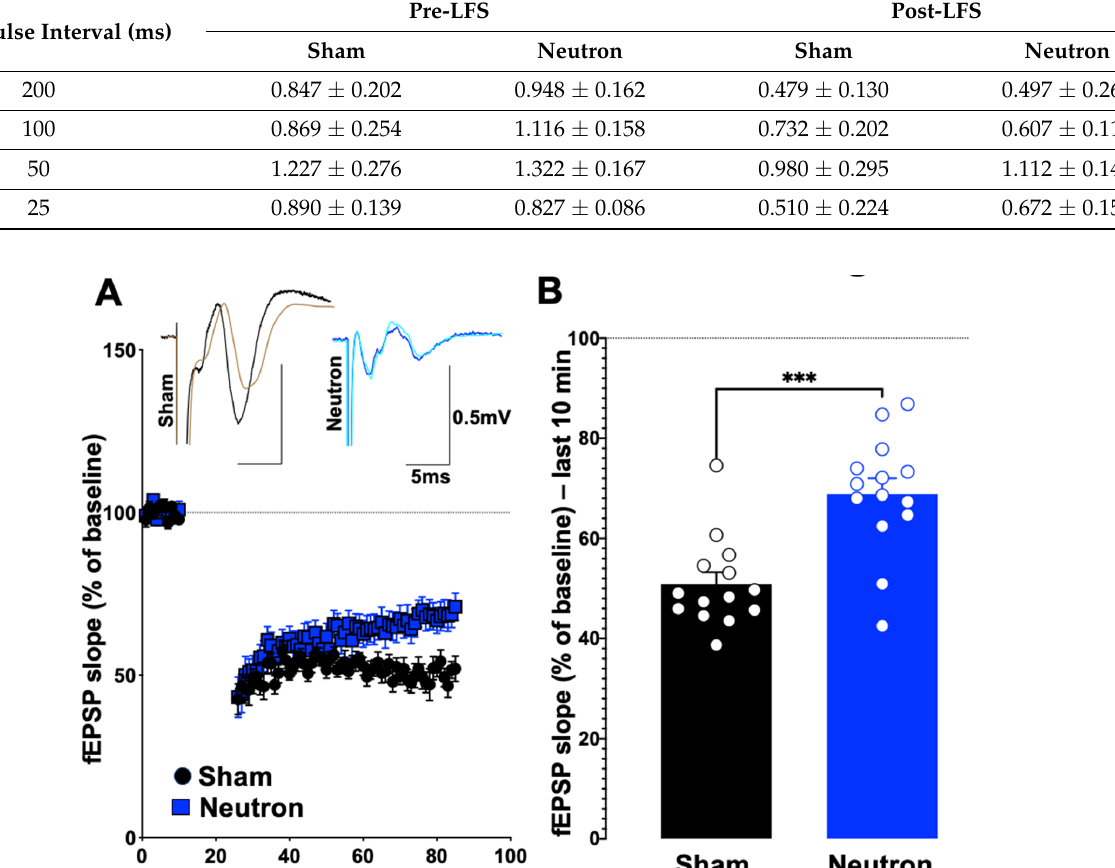
Table 1. Values represent the mean ± standard error of mean for n = 14 animals, calculated as the ratio of fEPSP slope values of the second response over the first response averaged over thirty sweeps. The assessment was conducted both before low frequency stimulation before baseline (LFS = 900 stimulations of 1 Hz, pre-LFS) and 60 min following LFS (post-LFS). No significant differences were observed at any of the above intervals.